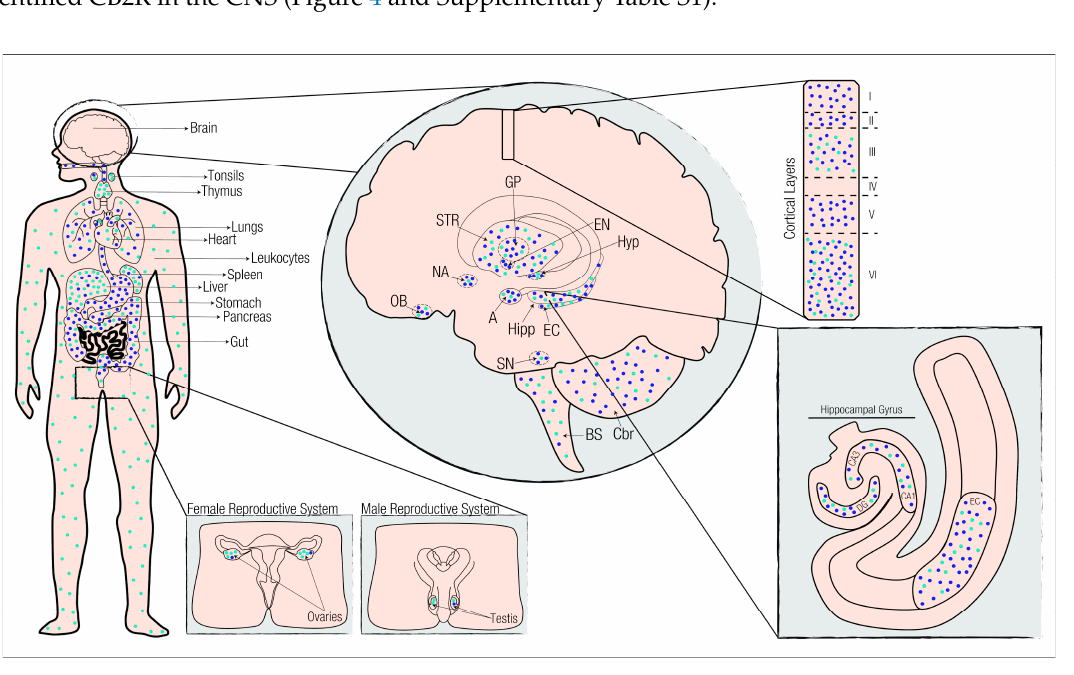
Figure 4. Expression of cannabinoid receptors in the CNS and peripherical tissues. The cannabinoid receptors display a di ff erential expression pattern dependent on the tissue. CB1R (dark blue) has higher expression on the CNS than in the periphery. CB2R (light blue), although predominantly expressed in the periphery is also expressed in the CNS. A = Amygdala; BS = Brainstem; CA1 = Cornu Ammonis 1; CA3 = Cornu Ammonis 3; Cbr = Cerebellum; DG = Dentate Gyrus; EC = Entorhinal c ó rtex; EN = Entopeduncular nucleus; GP = Globus Pallidus; Hipp = Hippocampus; Hyp = Hypothalamus; NA = Nucleus accumbens; OB = Olfactory Bulb; SN = Substantia Nigra; STR =